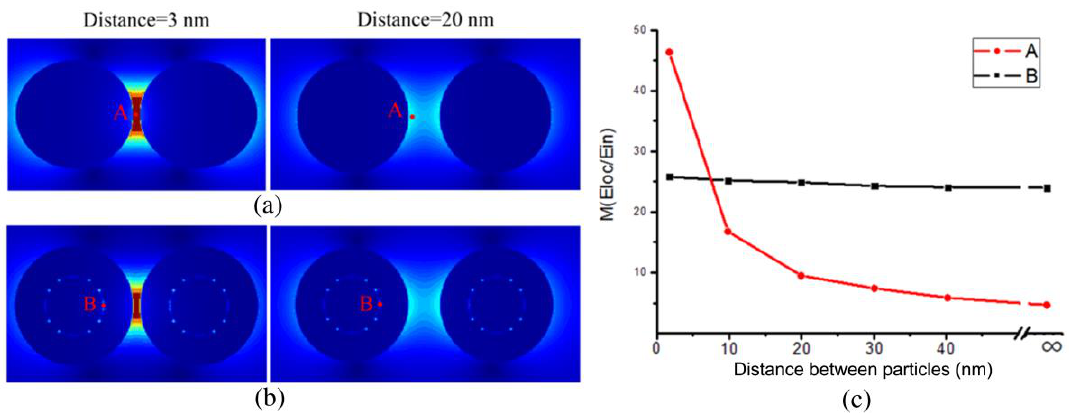
Figure 5. The simulated electromagnetic (EM) distributions of ( a ) two BGERTs with the interval distances of 3 nm and 20 nm respectively, ( b ) two Au nanospheres with the interval distances of 3 nm and 20 nm respectively, ( c ) the intensity variations of EM enhancement with the interval distances, in which A and B presented the reporter positions of Au nanospheres (a) and BGERTs (b), respectively.